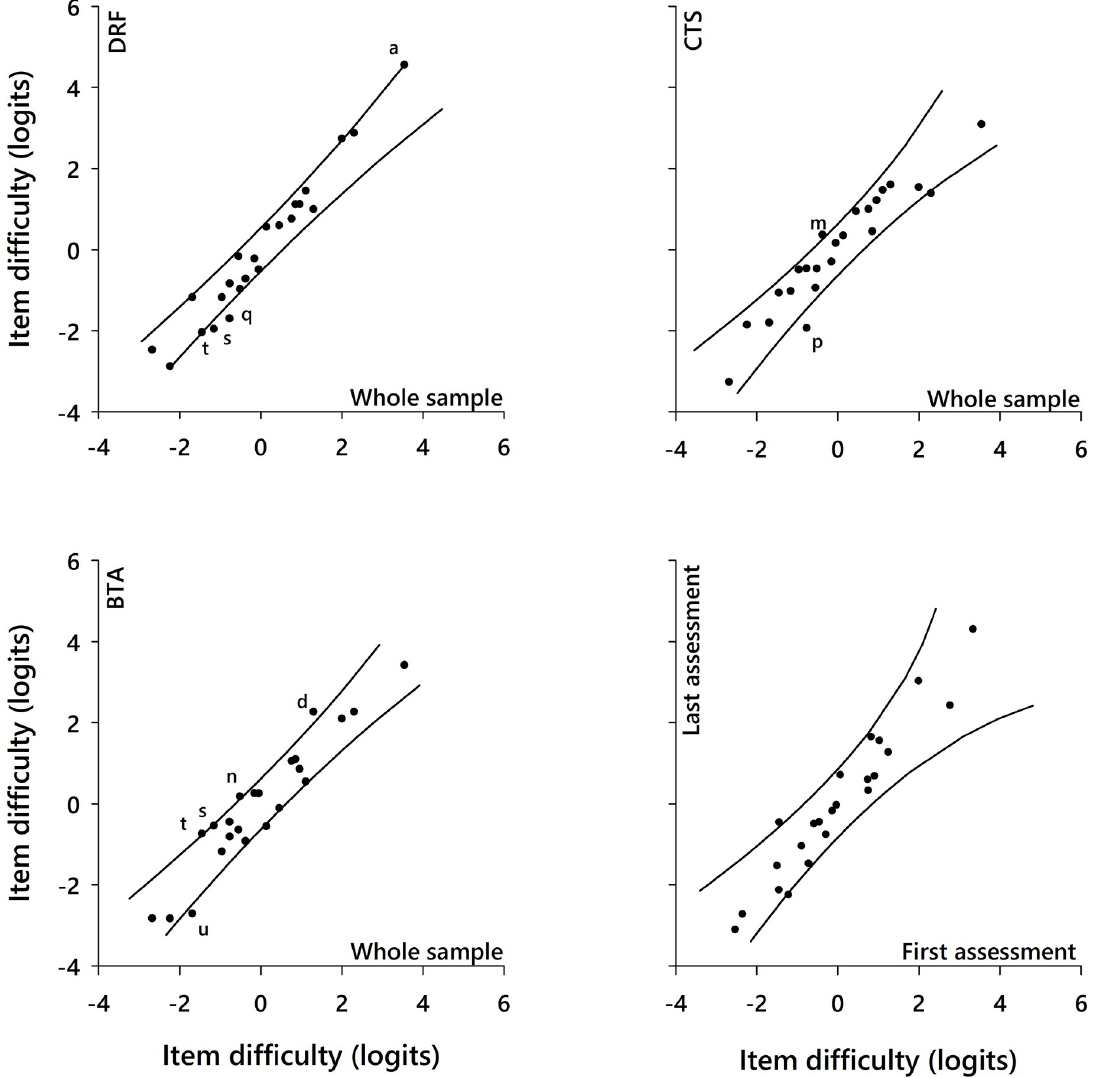
Fig 1. Differential item functioning (DIF) plots comparing the item difficulty hierarchy between subgroups. In each plot, the lines represent the 95% confidence interval of an ideal invariance between subgroups; the items are represented by the dots or by their letter if they display significant DIF. The most difficult items (dots) are plotted in the top right part of each plot. When comparing the item difficulty hierarchy between each diagnostic group relative to the whole sample, most of the ABILHAND-HS items lie within 95% confidence interval of the ideal invariance, indicating an invariant difficulty across diagnostic groups. When comparing the item difficulty hierarchy between the first and last assessment, all items fall within the 95% confidence interval of an ideal invariance, affirming invariance of item difficulties between the